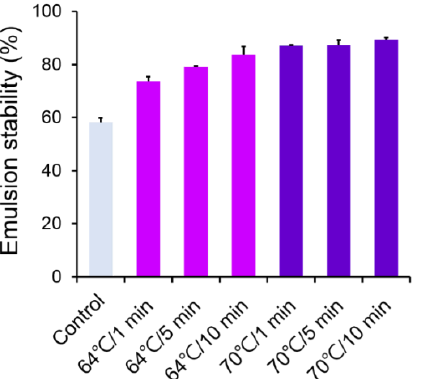
Figure 2. Effect of heating temperature and time on mayonnaise emulsion stability.